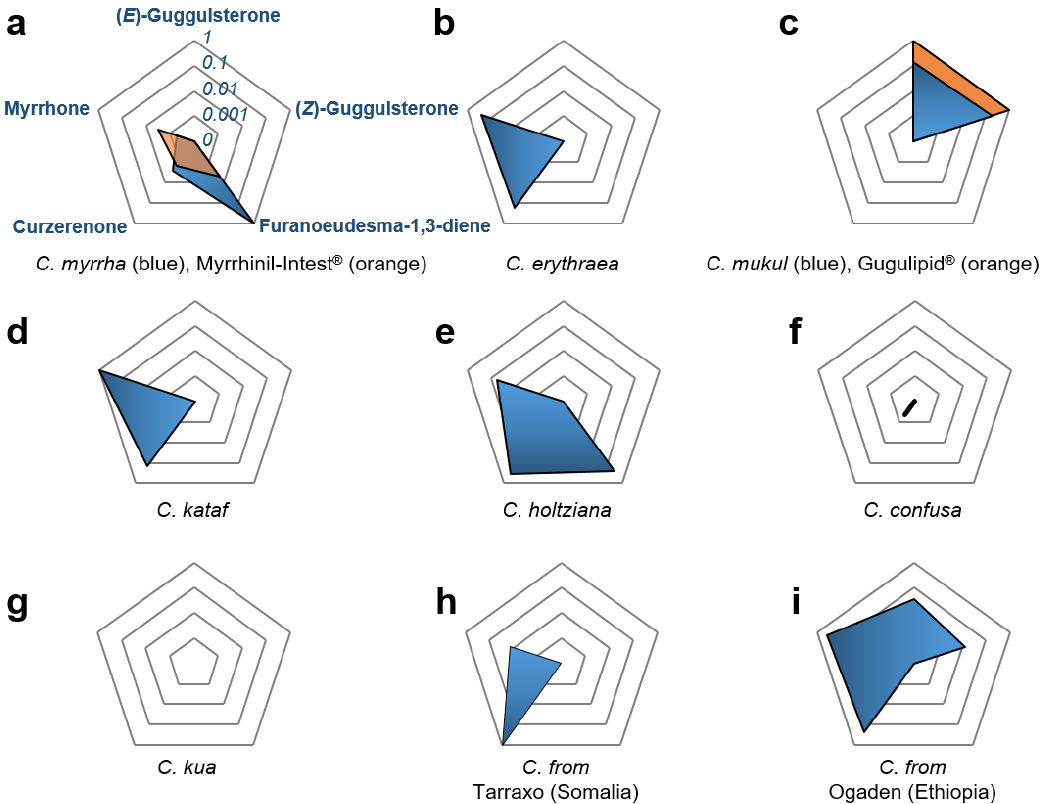
Figure 3. Radar charts visualizing the contents of ( E )-guggulsterone, ( Z )-guggulsterone, curzerenone, furanoeudesma-1,3-diene, and myrrhone in Commiphora oleogum resins from different species and locations as well as two Commiphora botanical drugs, Myrrhinil-Intest ® and Gugu- lipid ® . All contents are normalized and logarithmically scaled. ( a ) Composition of guggulsterones and furanosesquiterpenoids in C. myrrha (blue) and Myrrhinil-Intest ® (orange). Annotation and scal- ing correspond to all other radar charts. ( b ) C. erythraea . ( c ) C. mukul (blue) and Gugulipid ® (orange). ( d ) C. kataf . ( e ) C. holtziana . ( f ) C. confusa . ( g ) C. kua . ( h ) Commiphora oleogum resin from Tarraxo (Somalia). ( i ) Commiphora oleogum resin from Ogaden (Ethiopia). The particularly high contents of furanoeudesma-1,3-diene in C. myrrha were con- firmed by other studies and enable a differentiation between C. myrrha and C. erythraea which distribution areas overlap [28]. The typical myrrh odor is mainly attributed to a mixture of furanoeudesma-1,3-diene and lindestrene [3]. 2.3.2. Commiphora erythraea (Ehrenb.) Engl. Similar to C. myrrha , C. erythraea (var. glabrescens Engl.) is mostly found in northeast- ern Africa, such as Somalia, Eritrea, and Kenya. The oleogum resin obtained from C. ery- thraea is called “opopanax”, “bisabol myrrh”, or “perfumed bdellium”. Wheres C. myrrha represents the major source of myrrh today, C. erythraea was predominantly used in an- cient times [2,29]. C. erythraea oleogum resin contains moderate amounts of the furanosesquiterpenoids curzerenone (1.7 µg/mg) and myrrhone (0.6 µg/mg) and no furanoeudesma-1,3-diene (Figure 3b), which corresponds well to the literature [30]. Furthermore, no guggulsterones could be found in C. erythraea oleogum resin. The essential oil from C. erythraea contained mainly curzerene, β -elemene, β -bourbonene, and ( Z )- α -bisabolene, but was also deficient in furanoeudesma-1,3-diene (Table 4). For this species, especially ( Z )- α -bisabolene con- tributes to the typical odor of “opopanax” [1,31]. As mentioned before, the absence of furanoeudesma-1,3-diene allows a distinction from C. myrrha . This is of particular interest, as C. erythraea is frequently used as adulter- ation for C. myrrha [1,28] .